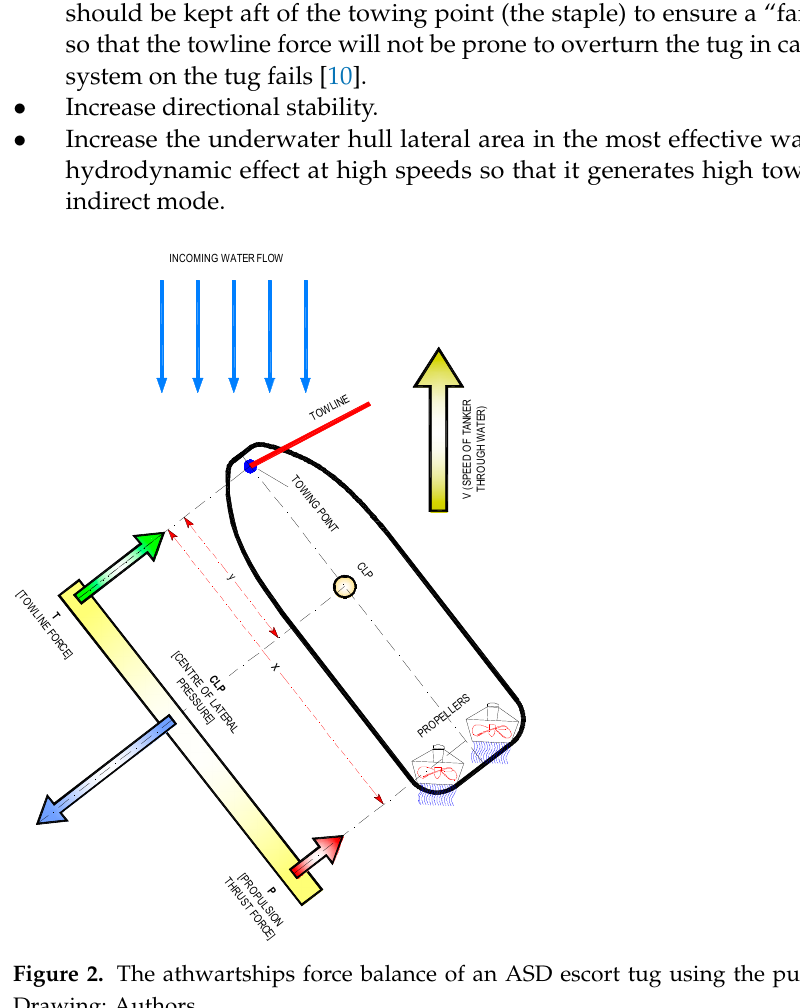
Figure 3. ( a , b ) The ASD escort tug “Costante Neri” delivered in September 2009 by Gondán Ship- yard, S.A. (Spain), to the owner Fratelli Neri S.p.A. (Italy). Photo: Authors.